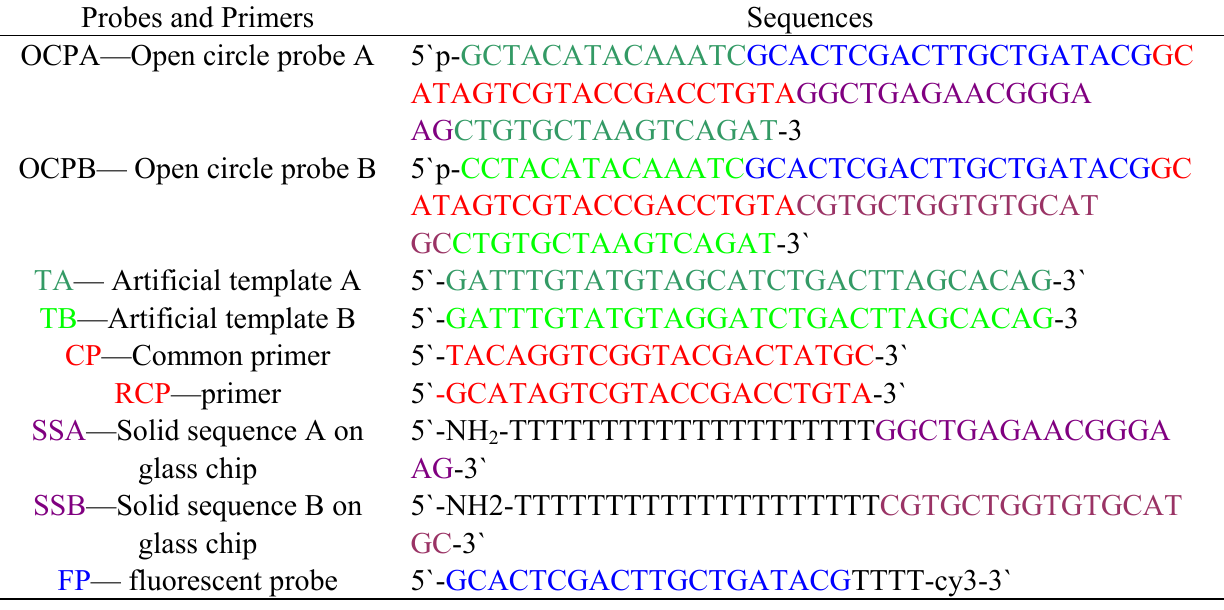
Table 1. Synthesized oligonucleotide sequences for experiment.